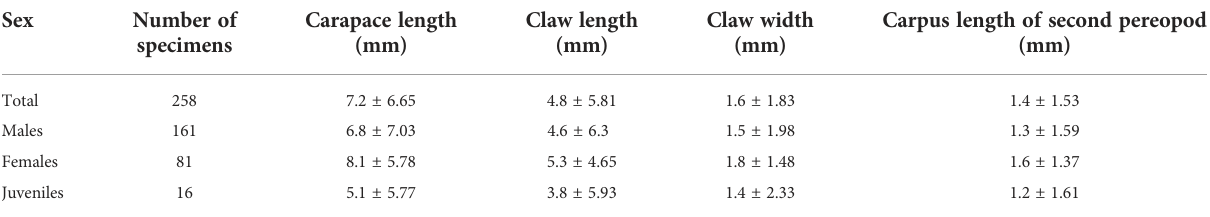
TABLE 1 Number of specimens of Kiwa puravida from Mound 12, Costa Rican Paci fi c margin, mean (± standard deviation) carapace length (mm), claw length and width (propodus of the fi rst pereopod, mm), and carpus length of the second pereopod (mm) of all specimens and by sex (males, females, and